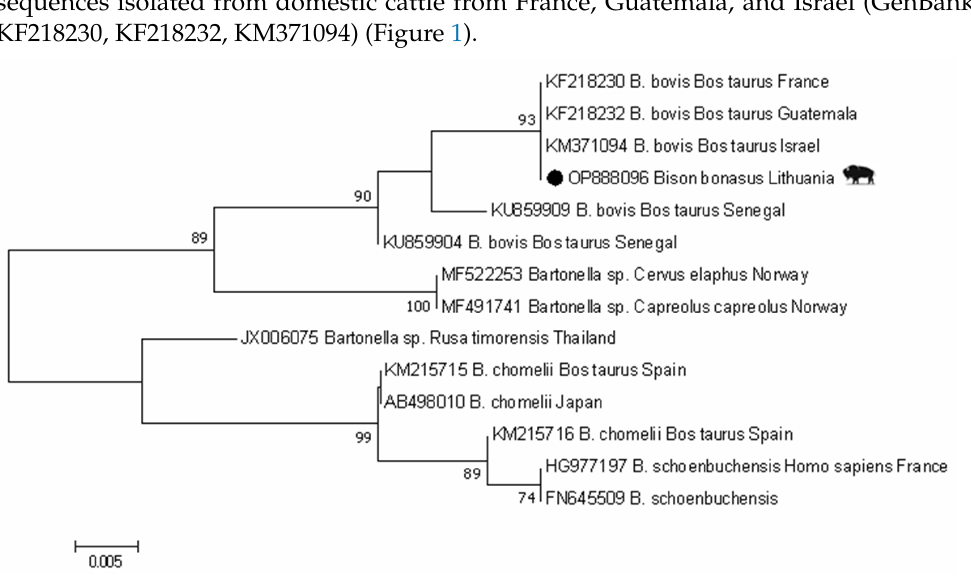
Figure 1. Phylogenetic tree of Bartonella spp. using 16S–23S rRNA ITS region sequences constructed by Maximum Likelihood method and Tamura–3 parameter model. Numbers on the tree indicate bootstrap support (values < 50% not shown). The identification source (host) and country are given after the accession numbers. Bartonella sample in this study isolated from European bison is marked with ● .